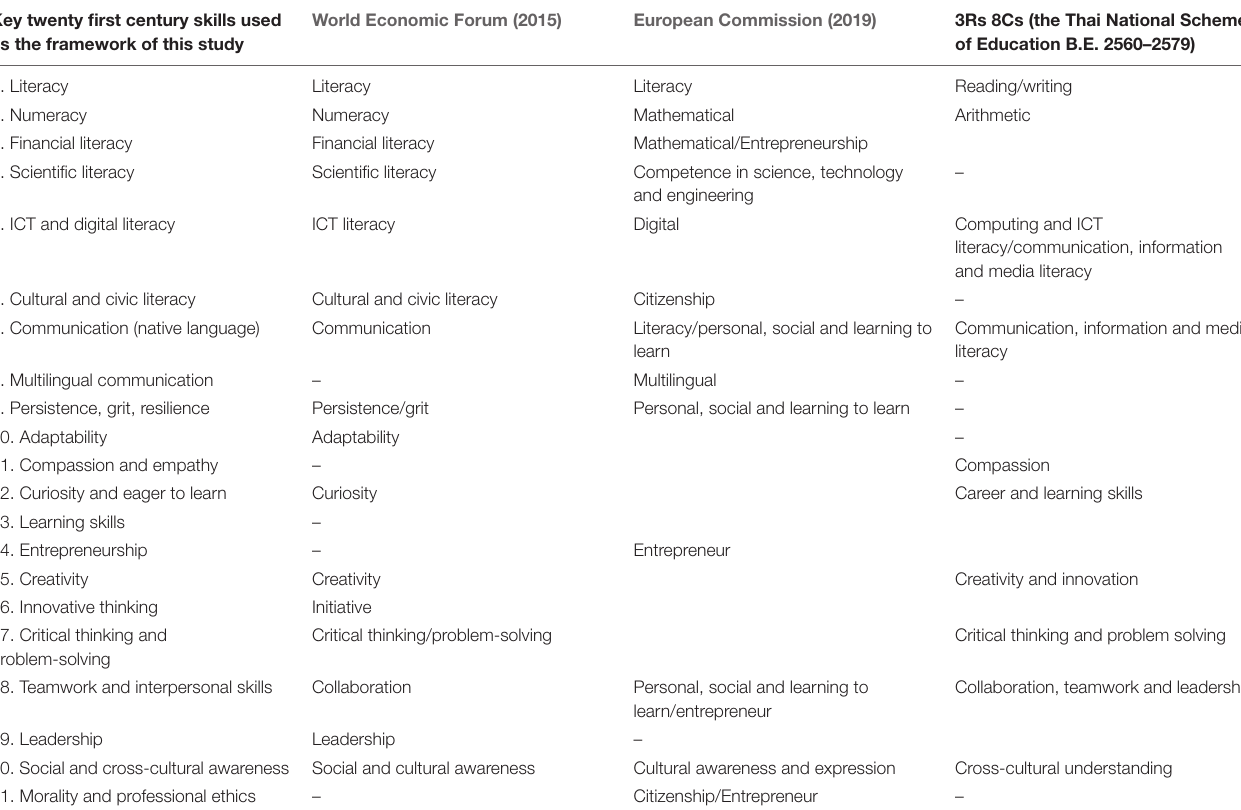
TABLE 1 | The twenty first century skills framework used in this study as compared to other key twenty first century skills